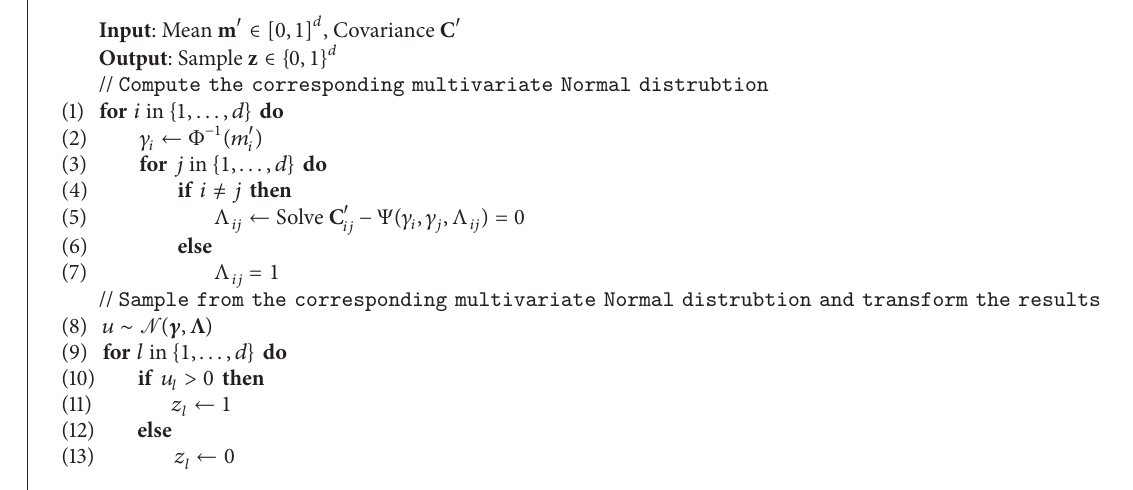
Algorithm 2: Sample from a multivariate Bernoulli